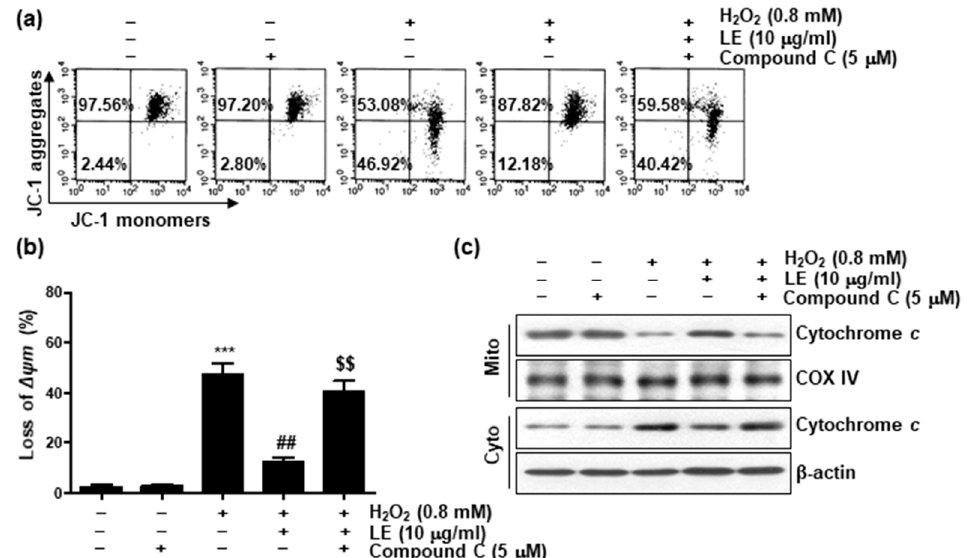
Figure 9. AMPK-dependent effect of LE on H 2 O 2 -induced mitochondrial dysfunction in C2C12 cells. Cells were pretreated with 5 µ M compound C, with or without 10 µ g/mL LE, for 1 h and then treated with 0.8 mM H 2 O 2 for 24 h. ( a ), ( b ) MMP was measured using JC-1 staining and flow cytometry: ( a ) Representative results of flow cytometry analysis are shown; ( b ) The proportion of JC-1 aggregates to monomers. Data indicate mean ± SD values ( n = 3; *** p < 0.001 vs. control cells; ## p < 0.01 vs. H 2 O 2 -treated cells, $$ p < 0.01 vs. H 2 O 2 and LE-treated cells); ( c ) Cytochrome c expression in mitochondrial and cytoplasmic fractions. Western blot analysis was performed using cytochrome c oxidase subunit IV (COX IV) and β -actin as internal controls for mitochondrial and cytoplasmic fractions, respectively. Representative results of three independent experiments are shown. Mito, mitochondrial fraction; Cyto, cytoplasmic fraction.